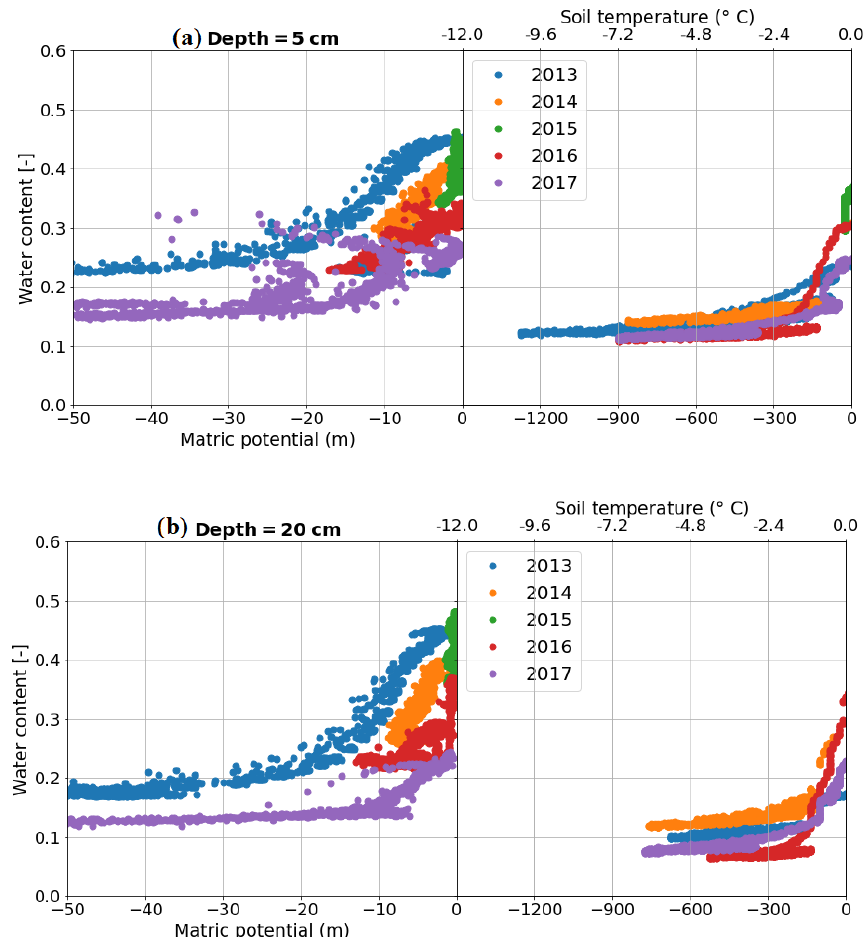
Figure 7. Observed soil water content and soil freezing characteristic of the upslope profile at depths of (a) 5 and (b) 20cm at St. Denis. Note that the water content data for the freezing condition of 2015 are not recorded in (b) since soil temperature at a depth of 20cm was always above 0 ◦